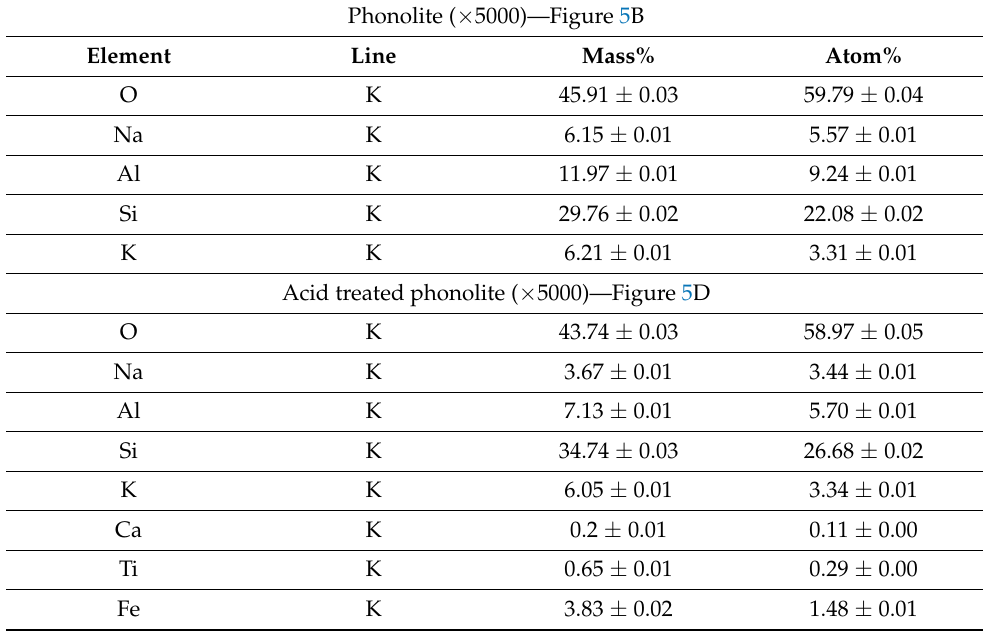
Table 2. EDS results. Element contents on the scanned surface (pictures at 5000 × shown in Figure 5).